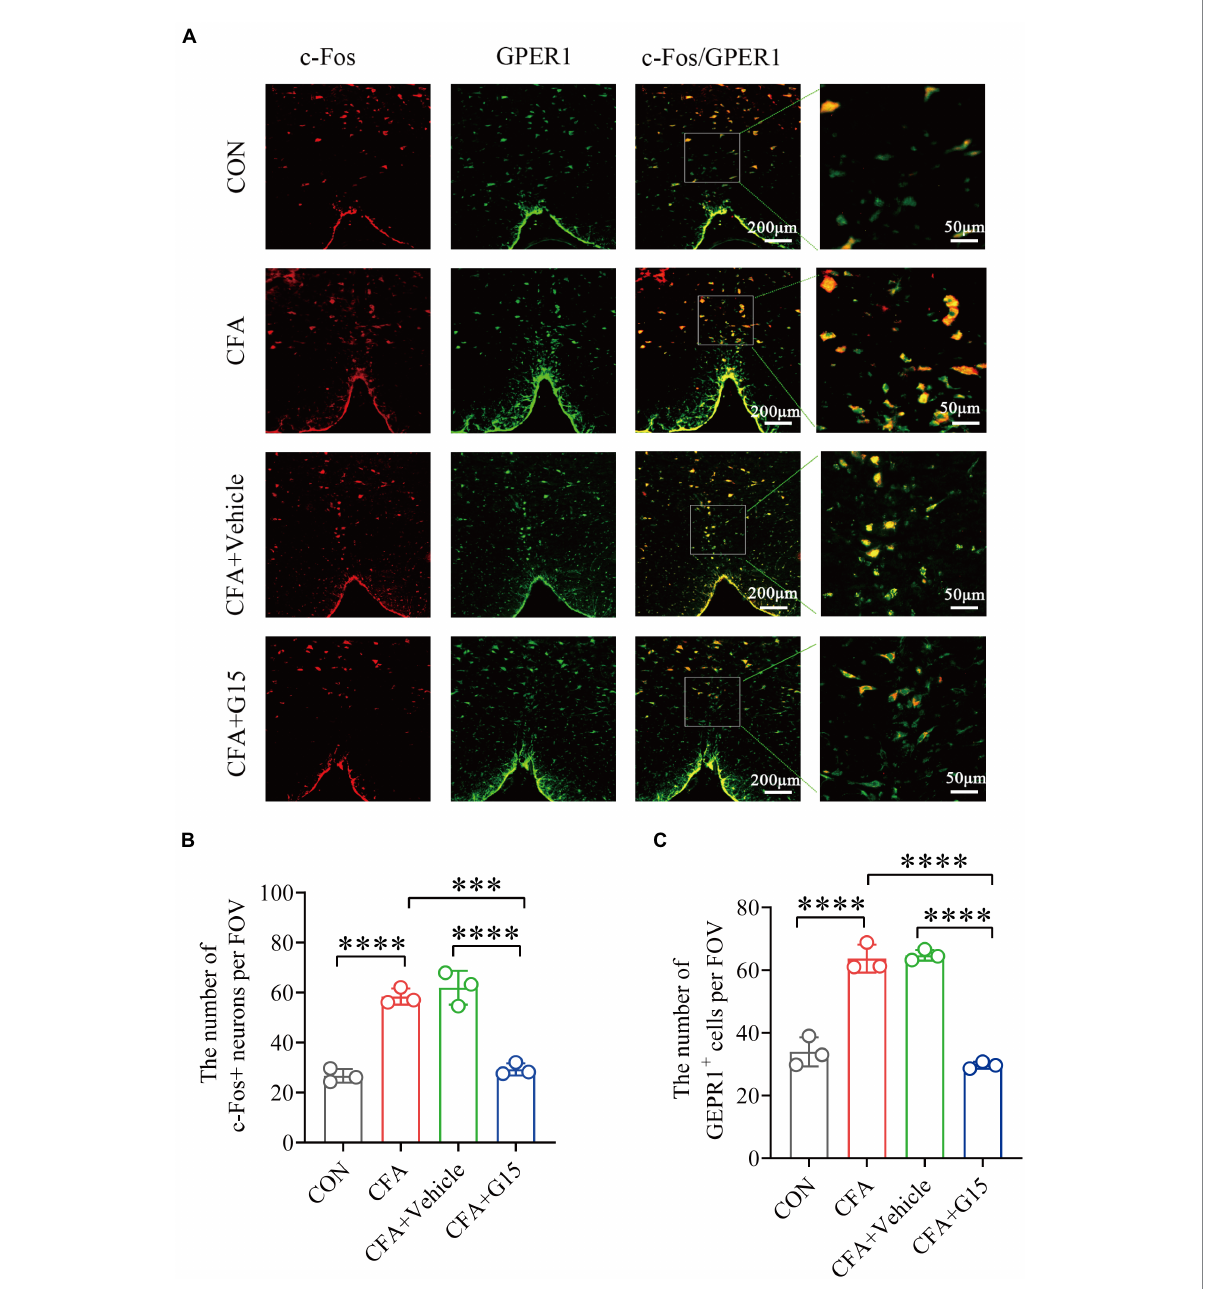
FIGURE 3 Number of activated GPER1-positive and c-Fos-positive cells in the RVM under different pain states. (A) Representative immunofluorescence images showing the distribution of c-Fos + and GPER1 + cells in the RVM of different pain states. White arrows show the c-Fos/GPER double positive (c-Fos + /GPER1 + ) cells. Red: c-Fos + neurons. Green: GPER + cells. Yellow: Indicates integrated signal. (B) Number of c-Fos neurons in the RVM of rats in different states. The number of c-Fos positive neurons was significantly reduced in the CFA + G15 group compared with the CFA group, while there was no significant difference between the CFA group and CFA + Vehicle group. (C) Statistical analysis of GPER1 + cells in the RVM of rats in different states. The number of GPER1 positive cells was significantly increased in the CFA group compared with the CON group. It was no significantly difference between the CFA group and CFA+ Vehicle group. Data represent the mean ± SD. All statistical analysis was performed using one-way ANOVA followed by the Tukey post hoc test for multiple group comparisons. *** p < 0.001, **** p < 0.0001. n = 3 per